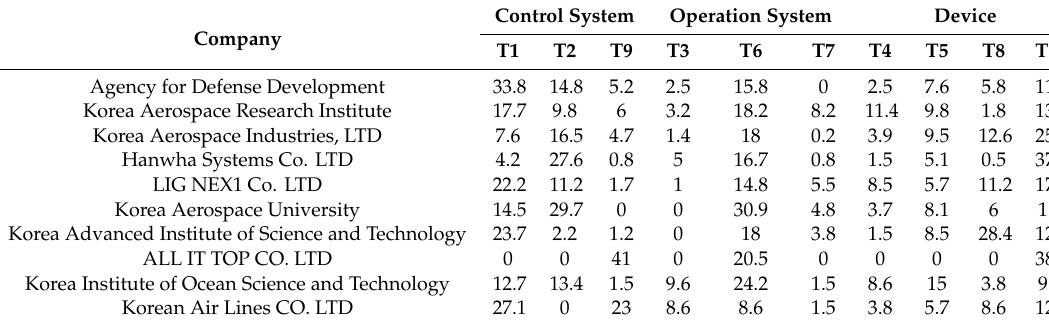
Table 2. Topic proportion of Korean aerospace companies.